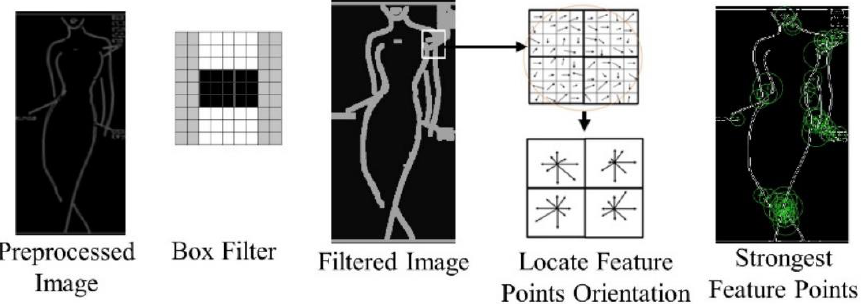
Figure 8. SURF feature points detected (shown as green colored dots) from a sample input image. The neighborhoods of feature points are drawn by green circles.